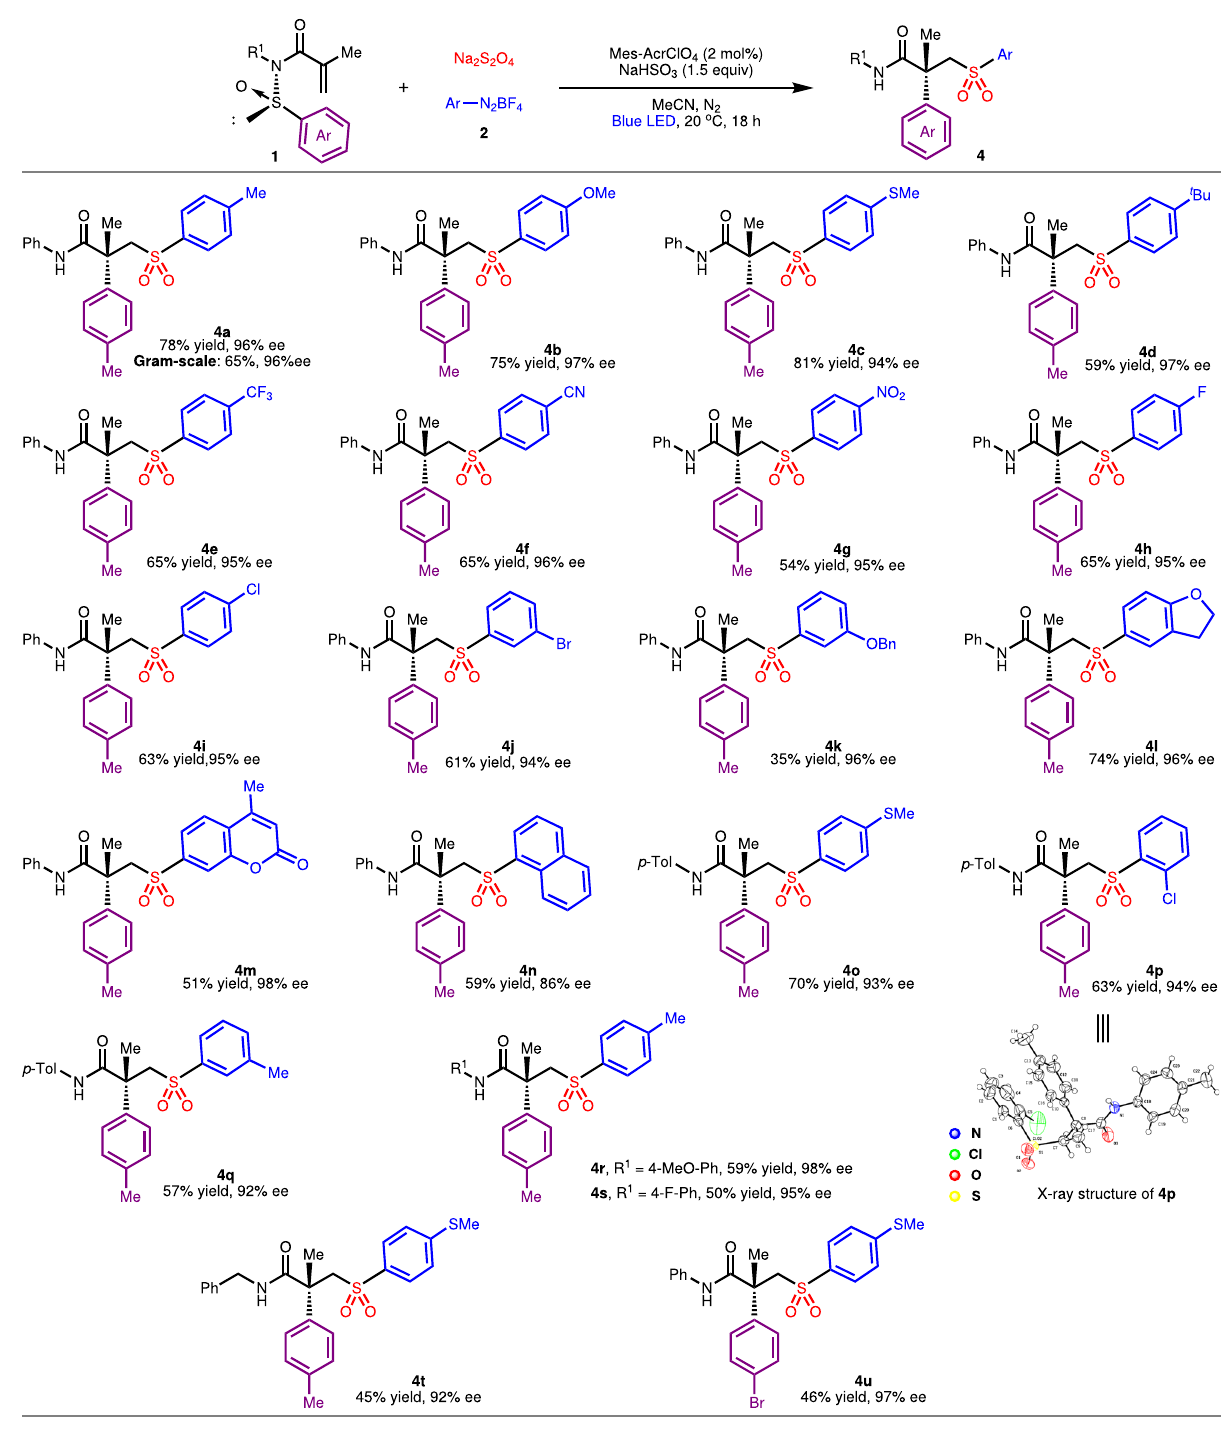
Fig. 2 | Generality of enantioselective Smiles rearrangement involving aryl- diazonium tetra fl uoroborates. Reaction conditions: 1 (0.2mmol), 2 (0.4mmol),